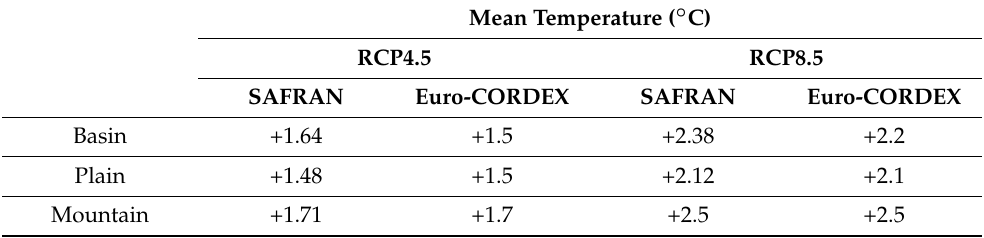
Table 5. Annual changes considering the mean of temperature (Tmax, Tmin) and precipitation (reduced or gain) by Euro-CORDEX and SAFRAN on the basin, the plains and mountain parts over